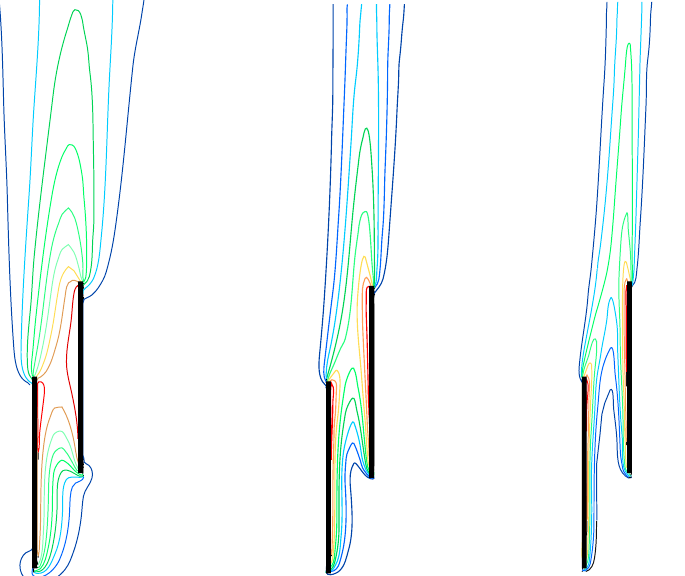
Figure 5. Isotherm contour plots for W / H = 0.25, L / H = 0.5 and Ra H = 10 4 , 10 5 , 10 6 using a scale from blue ( T = 0 ) to red ( T = 1 ) .